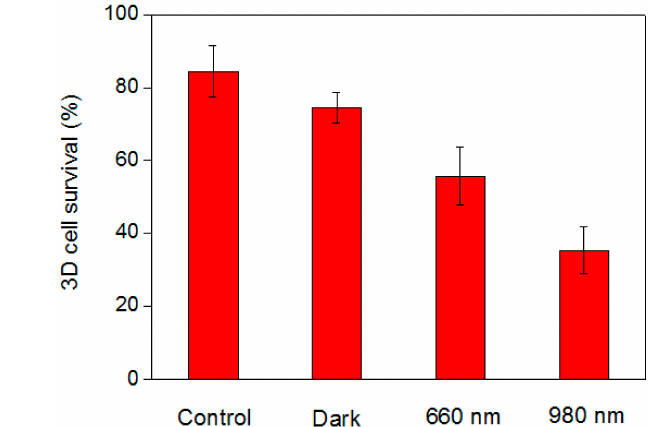
Figure 6. Fluorescence staining images for MCF-7 cells cultured in a 3D tumorsphere system: ( a ) control: live (calcein AM, green) and dead (EthD-1, red) cells in the absence of hybrid nanoparticles and light exposure; and ( b – d ) in the presence of hybrid nanoparticles in dark condition, and under 660-nm and 980-nm laser irradiation, respectively. ( e ) Quantitative analysis for the average distribution of live and dead cells in a tumorsphere with a standard deviation based on 10 spheres selected from the fluorescence images. The scale bar is 100 μ m.